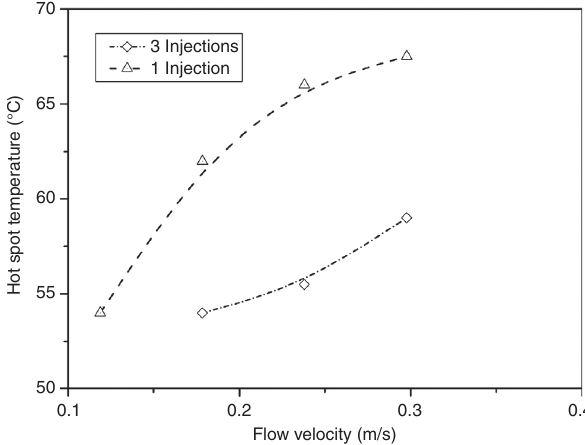
Figure 12 Maximum temperature while carrying out cyclization of pseudoionone in the multi-injection reactor with one injection point and with three injection points.